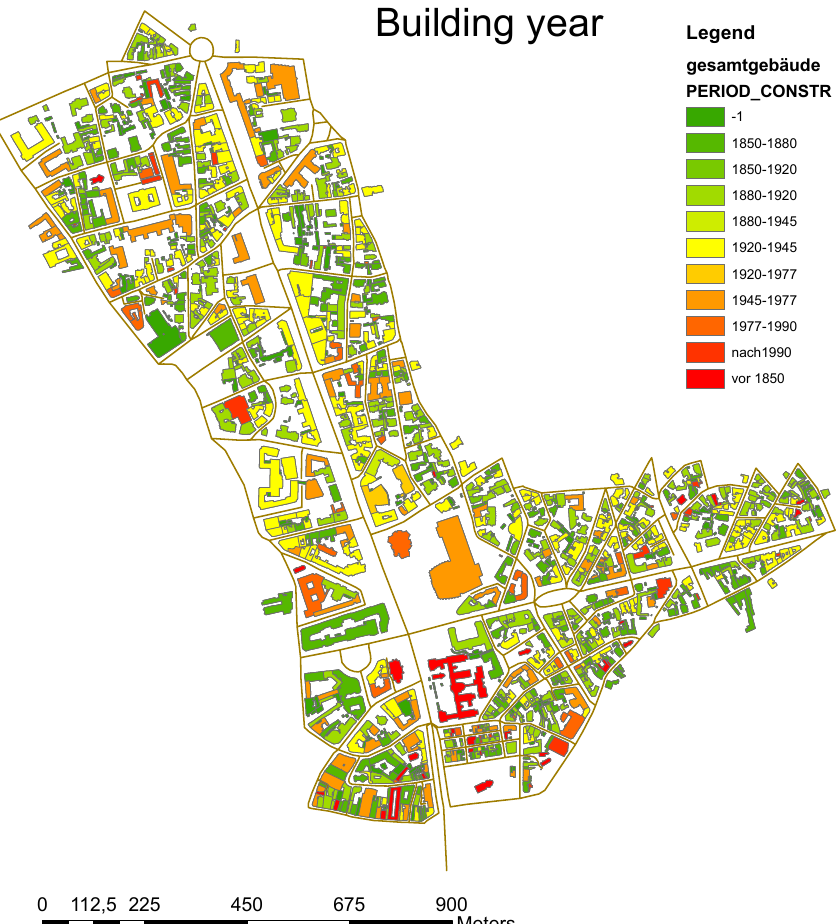
Fig. 2. GIS map of the areal investigated in SFB461, displaying the age of the buildings along the N-S Modernist